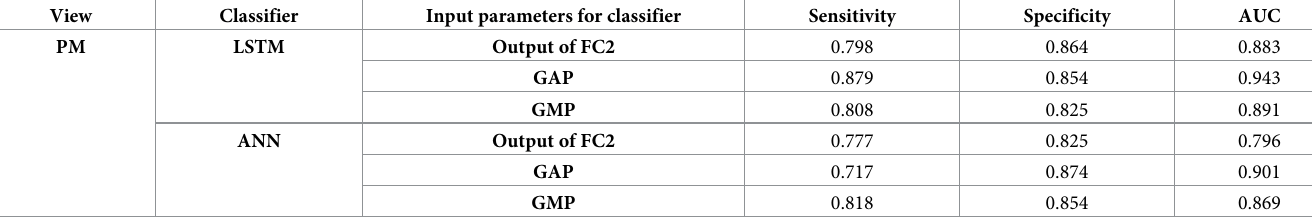
Table 8. Results of short-axis papillary muscle view